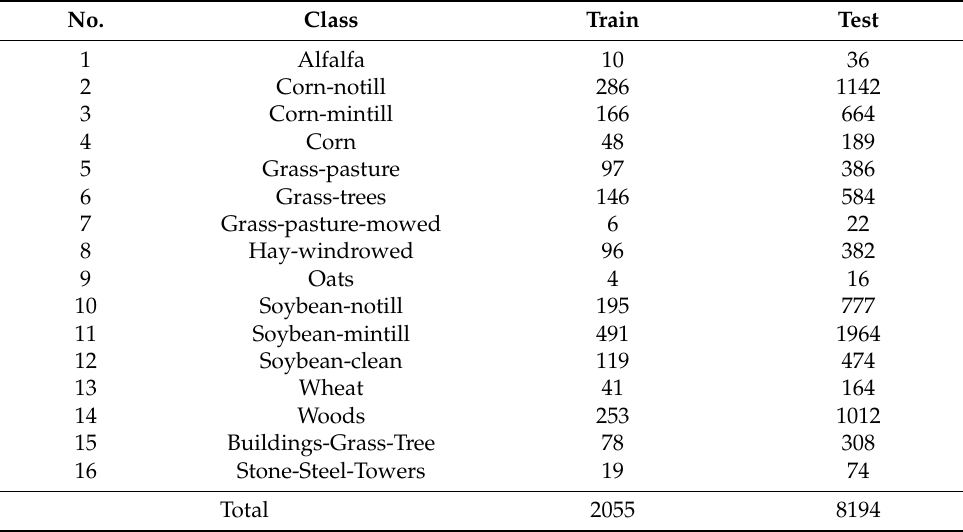
Table 3. Land cover class information for the IP